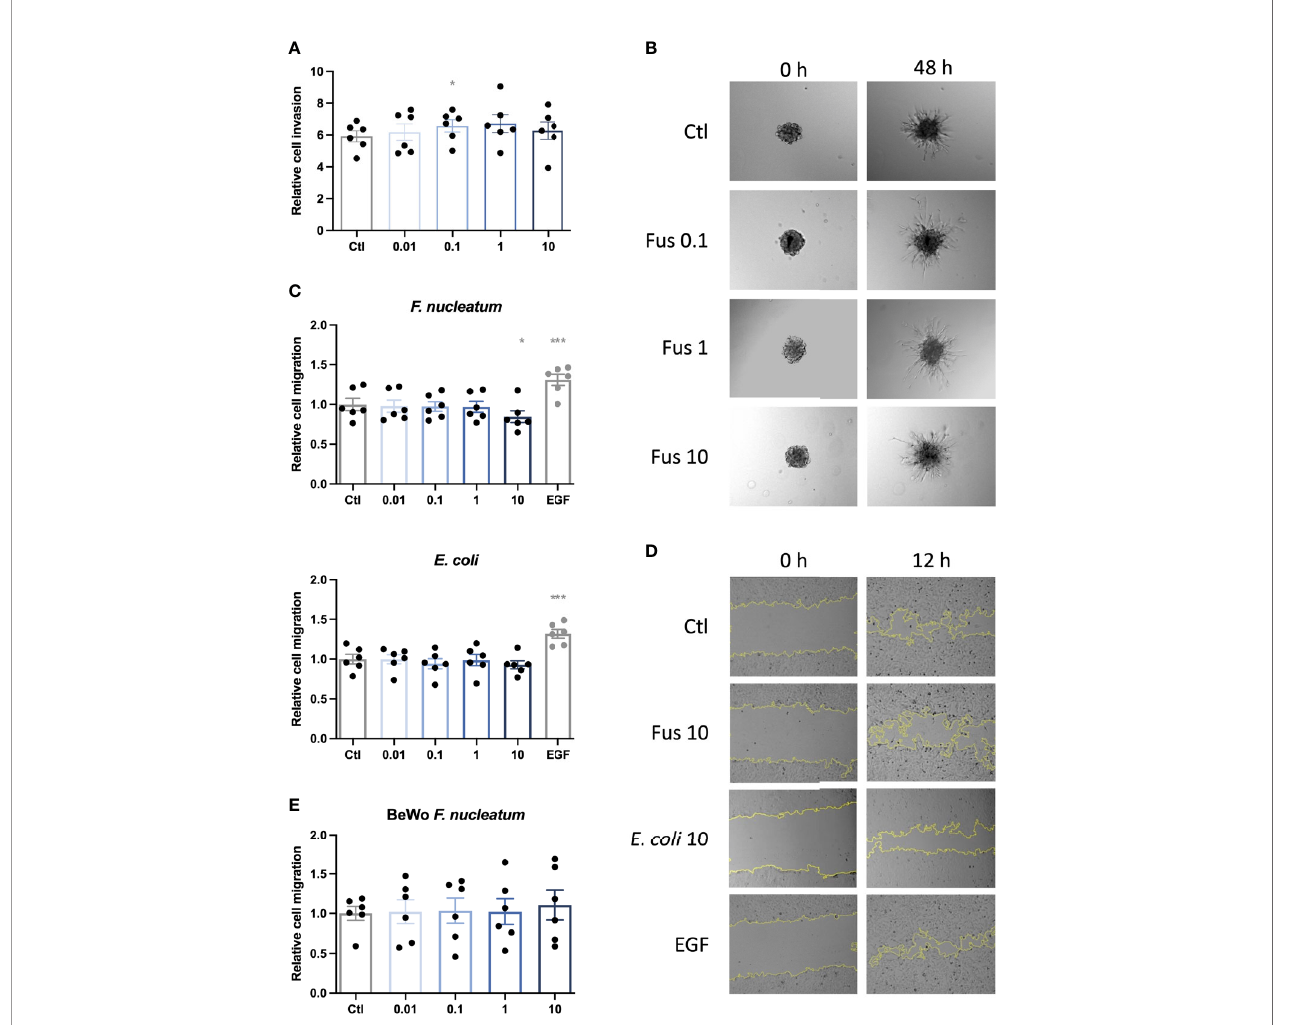
FIGURE 2 | Low concentrations of inactivated F. nucleatum promote HTR8/SVneo invasion; high concentration of inactivated F. nucleatum impairs migration of HTR8/SVneo cells. HTR8/SVneo cells were stimulated with F. nucleatum for 6 h using indicated bacteria:trophoblast ratios. After culture in methyl cellulose- containing medium, spheroids were embedded in matrigel and observed to analyse invasive behaviour (A, B) . Bar graph shows relative sprouting expansion after 48 h normalized to spheroid size at 0 h (A) . Data are presented as mean ± SEM and were analysed by Repeated Measures ANOVA with Dunnett ’ s multiple comparison post test, comparing each treatment against the corresponding control. *p adj < 0.05 Representative microscopic images are shown (B) . Experiments were performed 6 times. Scratch assay was performed to assess the migratory behaviour of bacteria-treated trophoblasts (C – E) . EGF was used as positive control. Inactivated bacteria were added in different ratios (0.01; 0.1; 1; 10 bacteria per trophoblast cell). Bar graphs represent relative area recovered by HTR8/Svneo treated with either F. nucleatum (above) or E . coli (below) after 12 h (C) or BeWo treated with F . nucleatum after 30 h (E) normalized to unstimulated control. Data are presented as mean ± SEM. *p adj < 0.05; ***p adj < 0.001 as analysed by Repeated Measures ANOVA with Dunnett ’ s multiple comparison post test, comparing each treatment against the corresponding control. Experiment was performed 6 times in quadruplicate (C) or triplicate (E) . Each point represents the mean value of the replicates for each experiment. Representative microphotographs of HTR8/SVneo taken with a 10 × objective taken after 0 and 12 h of the scratch (D) . EGF, epidermal growth factor; Ctl,